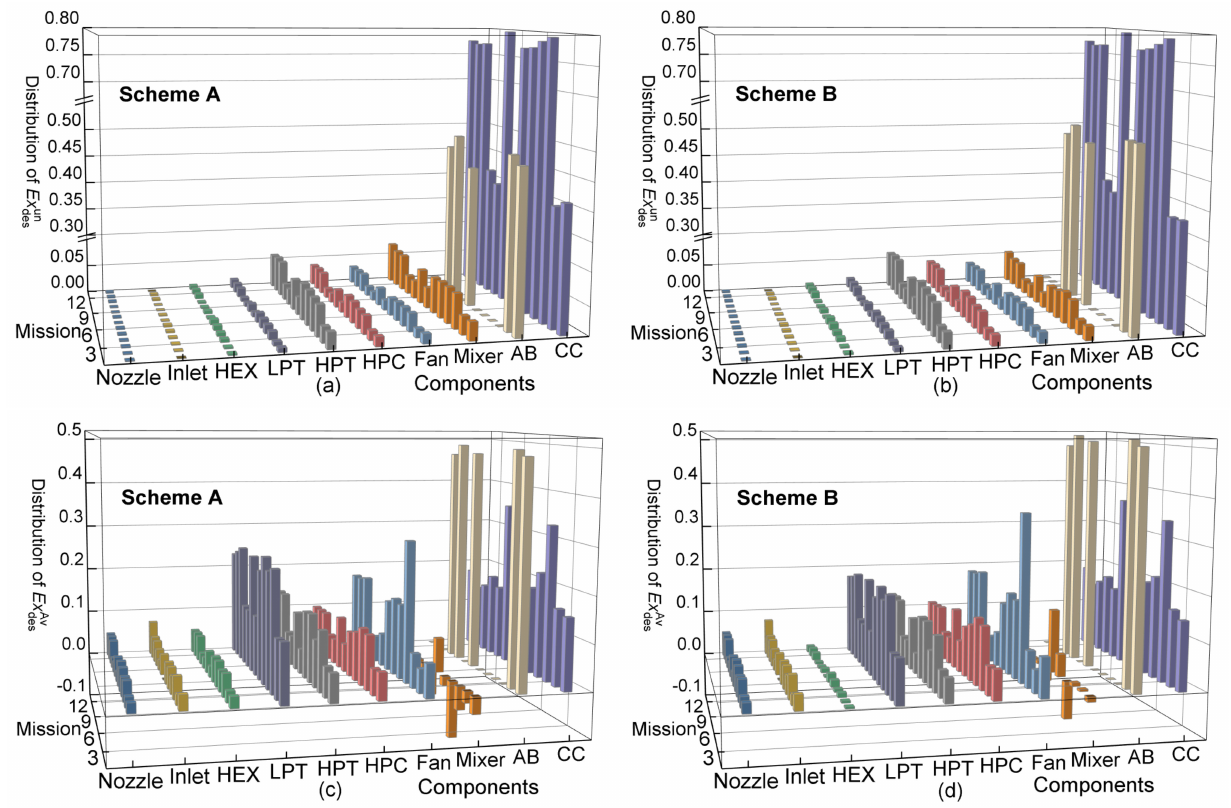
Figure 11. ( a ) The distribution of unavoidable exergy destruction in Scheme A; ( b ) The distribution of unavoidable exergy destruction in Scheme B; ( c ) The distribution of avoidable exergy destruction in Scheme A; ( d ) The distribution of avoidable exergy destruction in Scheme B.